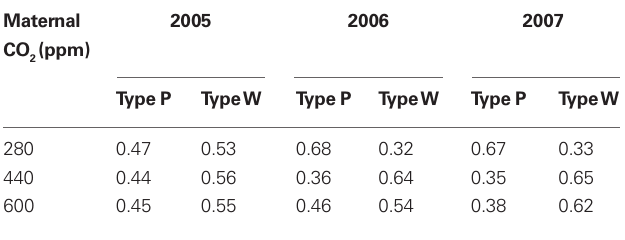
Table 1 | Fraction of plant types randomly allocated to maternal CO treatments in the three experimental